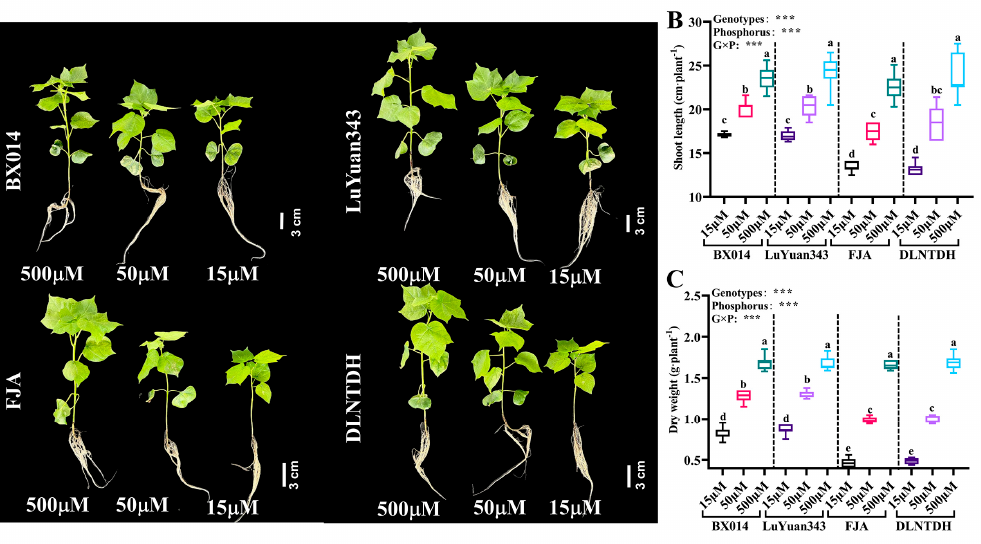
Figure 2. ( A ) Phenotypes of varieties with different P efficiency under different P treatments; ( B ) shoot length, and ( C ) dry weight at 28 days after various P treatments. The results are expressed as means ± SE ( n = 7). Statistically significant changes are indicated by different letters using the two-way ANOVA and multiple-comparison test ( p ≤ 0.05). p -values of the ANOVAs of genotypes (G), phosphorus level (P), and their interaction (G×P) are indicated as ns, not significant; ***: p < 0.001.